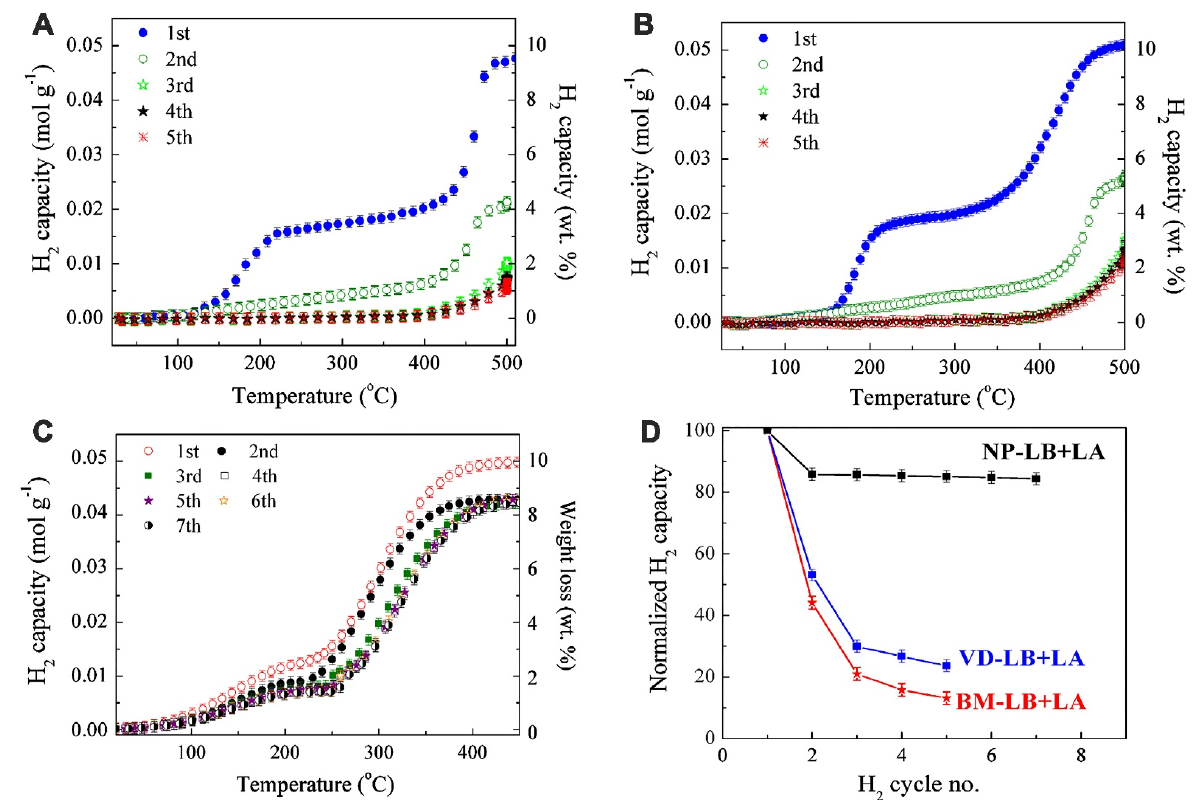
Figure 6. Evolution of consecutive H 2 desorption curves: five cycles for the ball milled ( A ) and vacuum-dried ( B ) composites; ( C ) seven cycles for the nanoconfined 2LiBH 4 –LiAlH 4 composite and ( D ) normalized H 2 capacity as a function of cycle number for the post milled, vacuum-dried and nanoconfined 2LiBH 4 –LiAlH 4 composites, respectively. Figure is reprinted with permission from ref. [179].